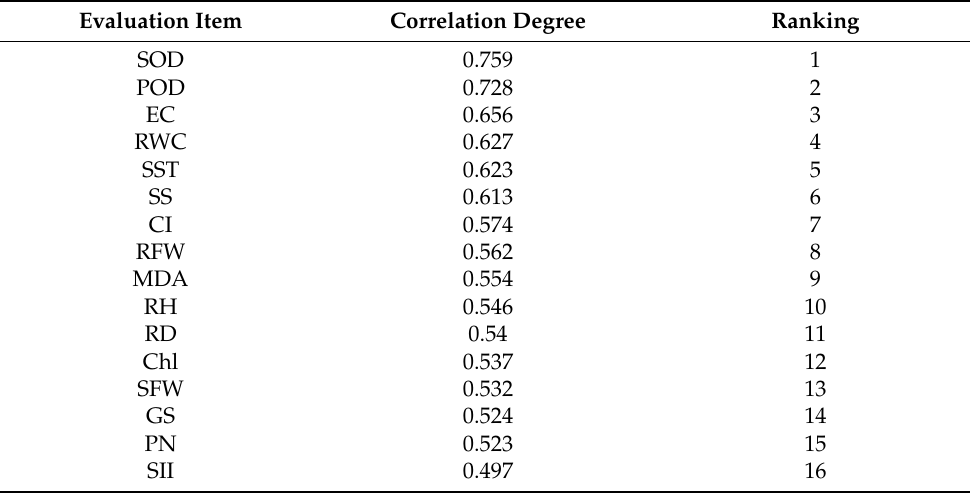
Table 4. Grey correlation degree of every single index.